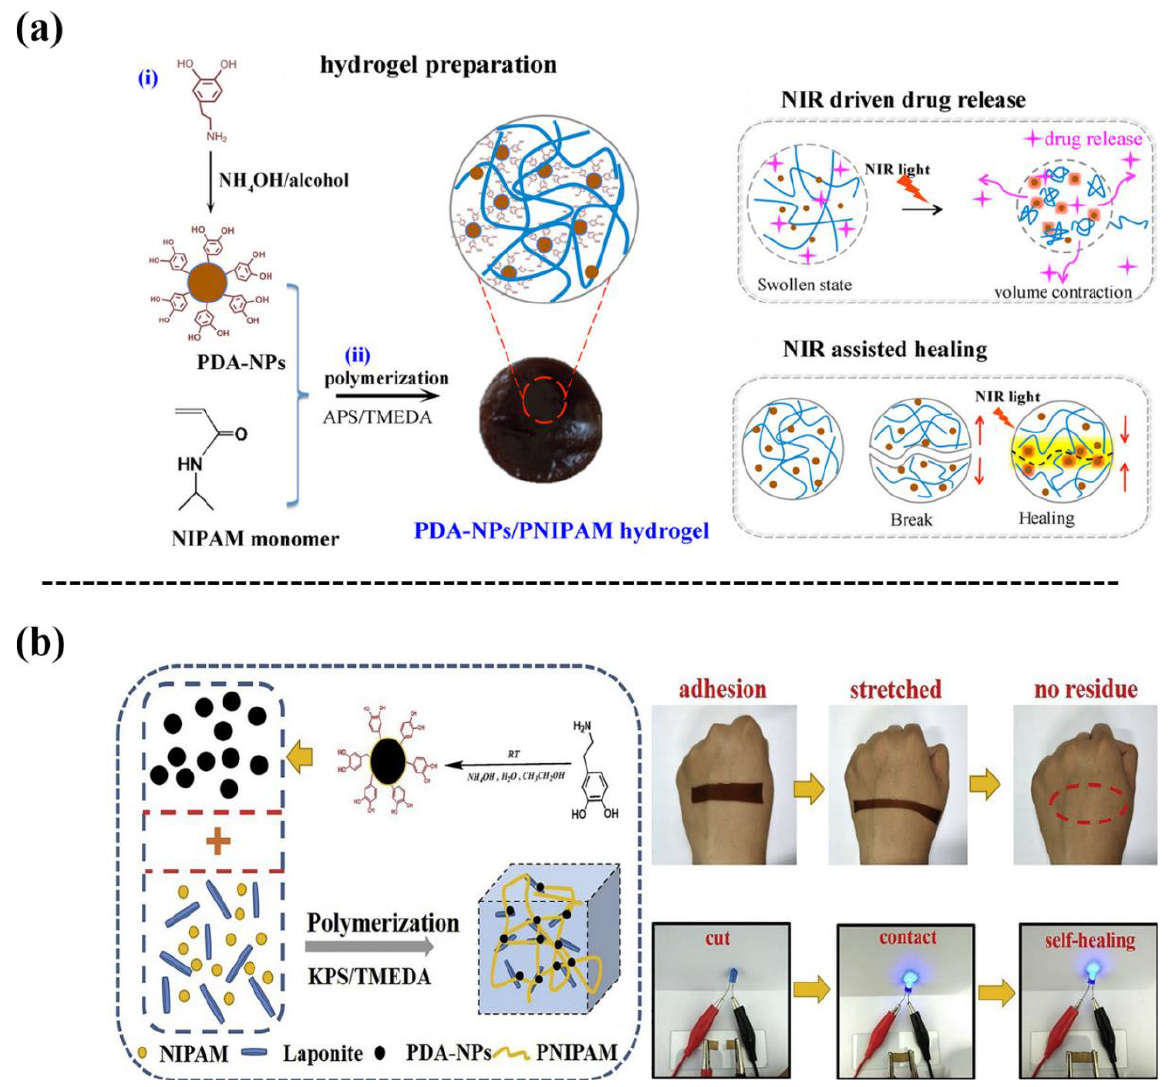
Figure 8. ( a ) Incorporating PDA-NPs into a PNIPAM hydrogel to fabricate a PDA-NPs/PNIPAM hydrogel with NIR responsiveness, self-healing, on-demand drug releasing, and adhesive properties [67]. ( b ) Fabrication of a PDA-NPs and laponite-embedded nanocomposite hydrogel with stretchability, conductivity, dual light- and thermo-responsive, and adhesive properties [68].